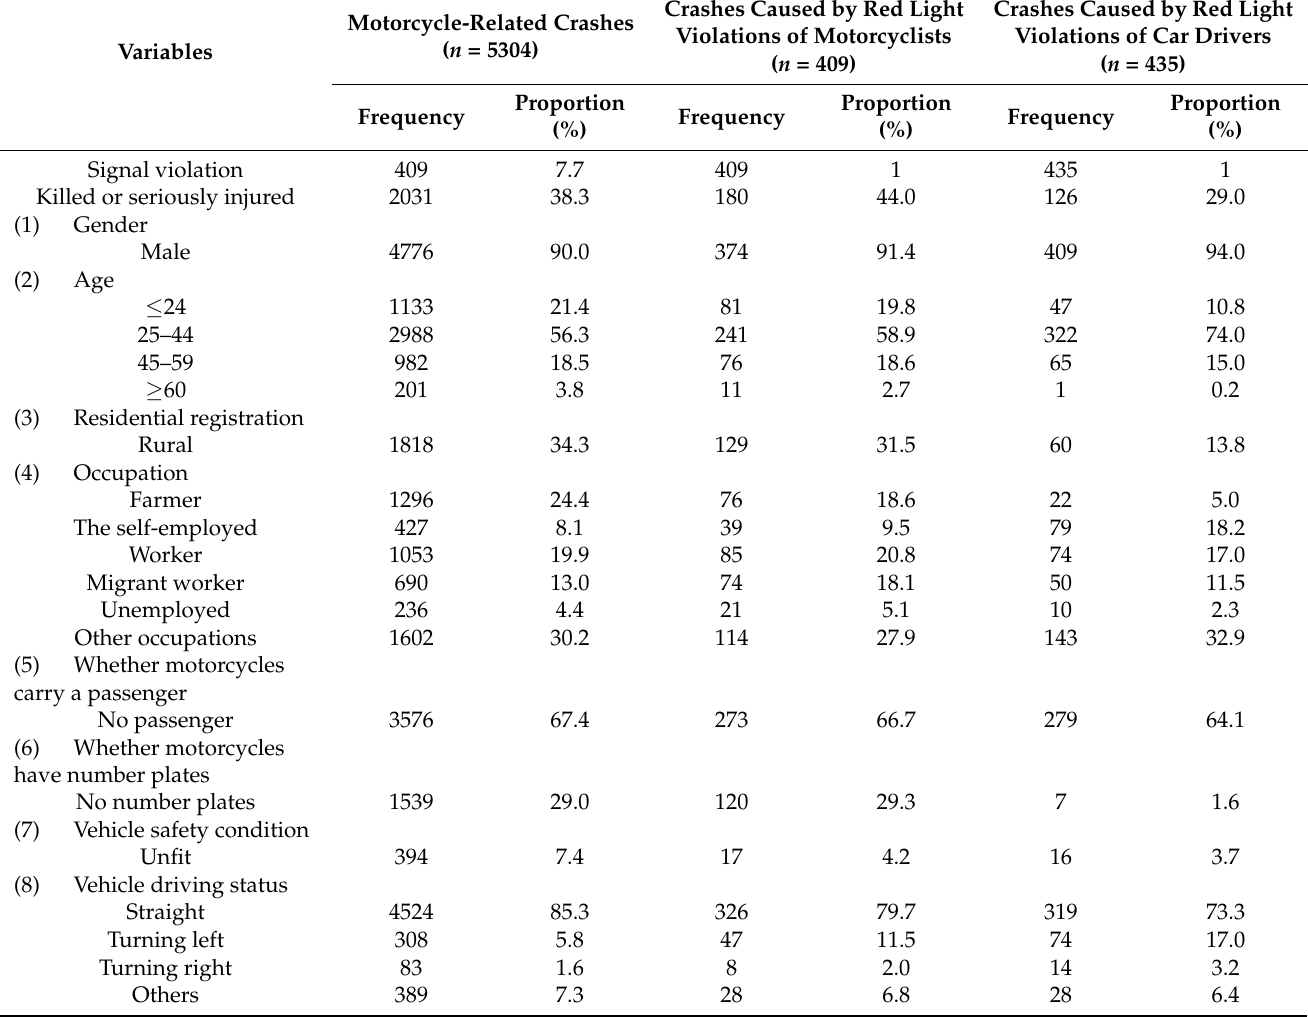
Table 1. Descriptive statistics of